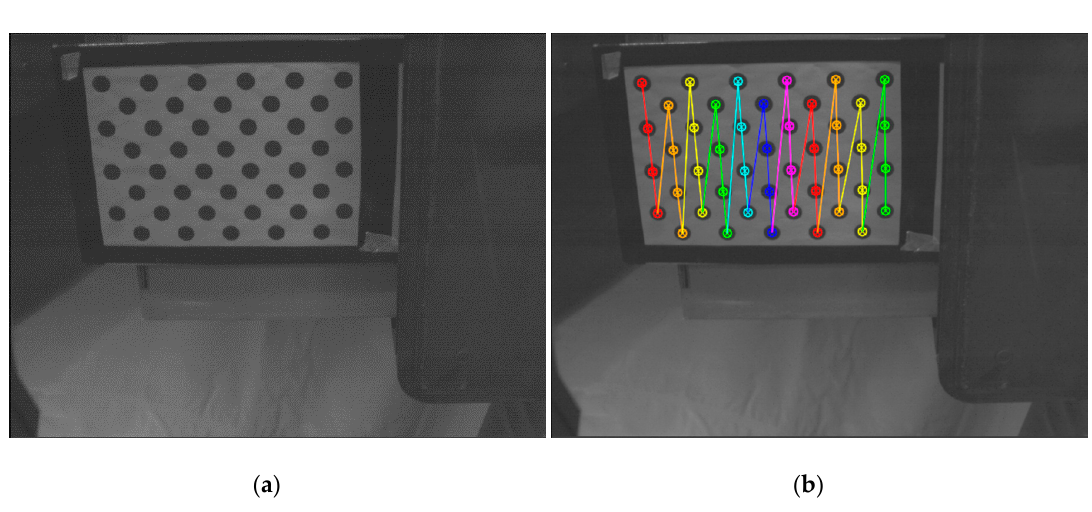
Figure 8. An exemplary image of the calibration pattern: ( a ) raw image; ( b ) image with extracted centers of the circles used to calibrate the camera.